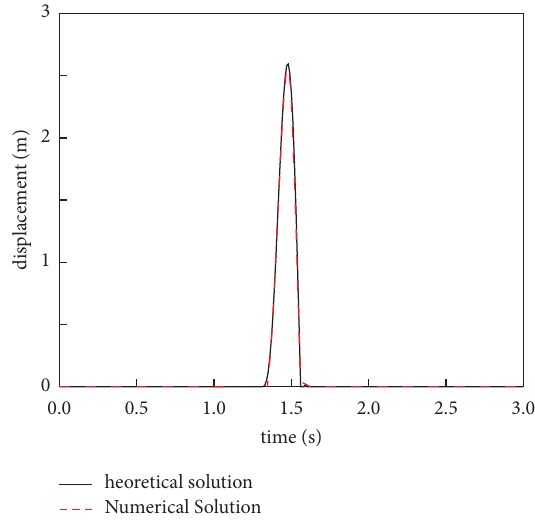
Figure 5: Displacement time history curve. Figure